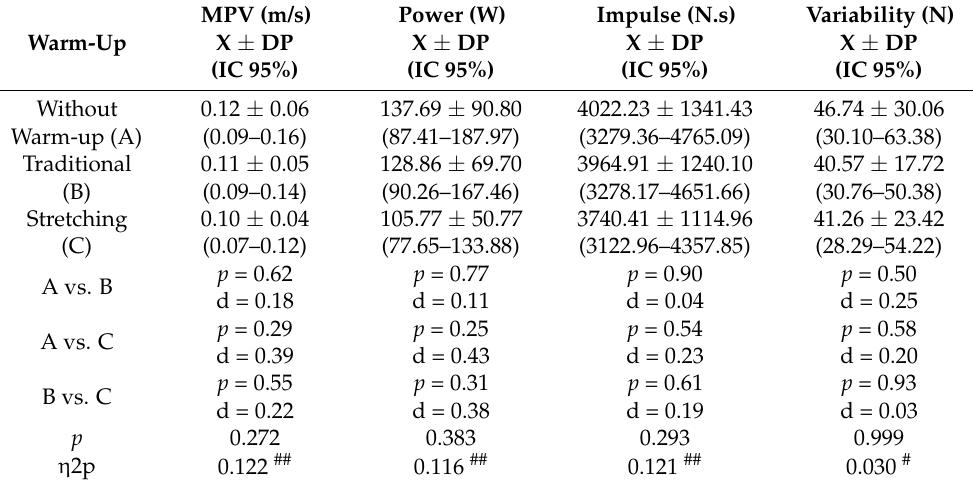
Table 1. Dynamic and static force indicators (mean ± standard deviation, 95% CI) in relation to different types of warm-up.